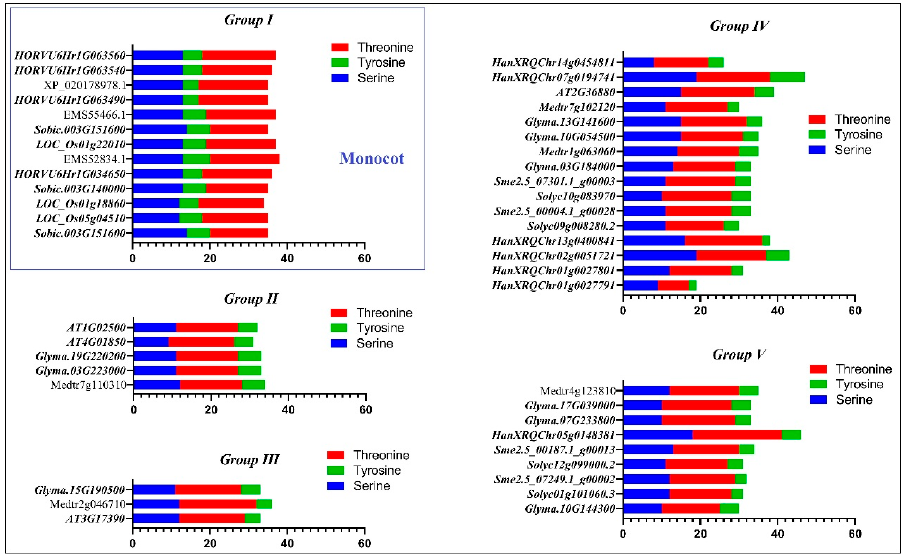
Figure 4. Predicted phosphorylation sites of SAMS proteins in different plant species determined using the NetPhos 3.1 server.